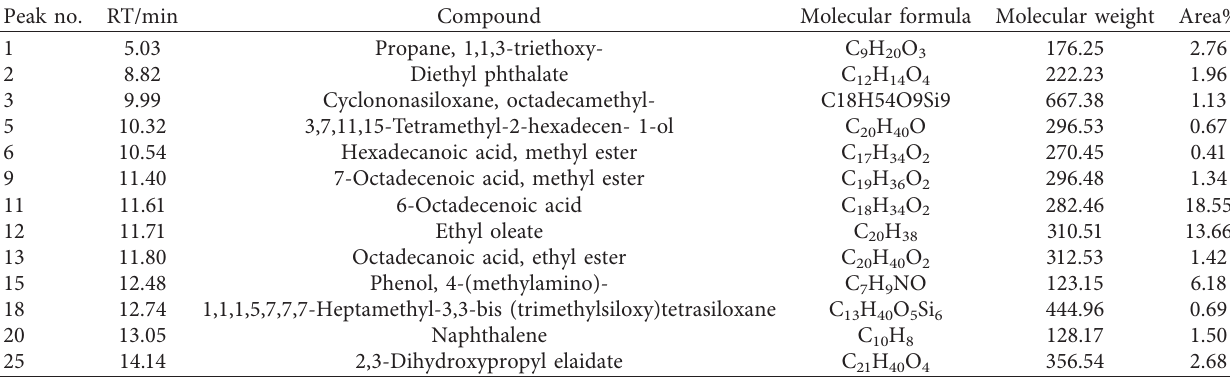
Table 5: Interpretation of GC-MS analysis: identified compounds that are contained in ETH only. Peak no. RT/min Compound